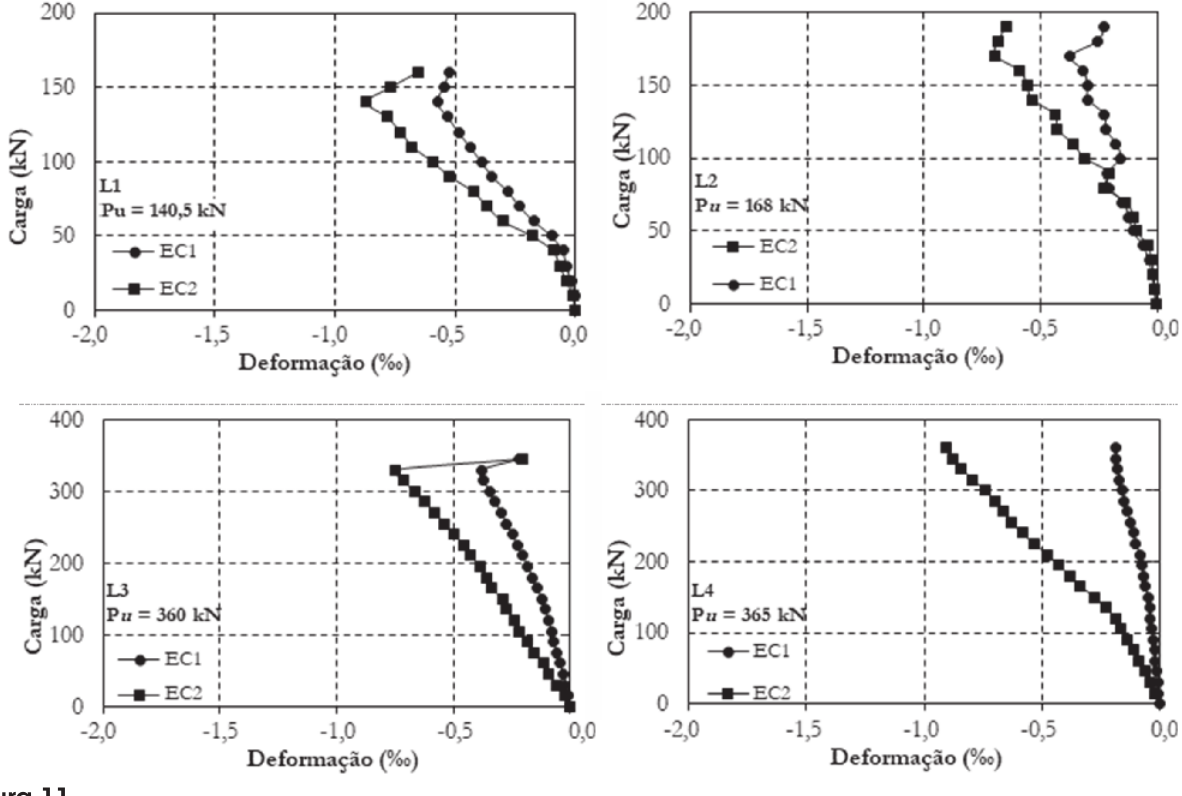
Deformações do concreto das lajes